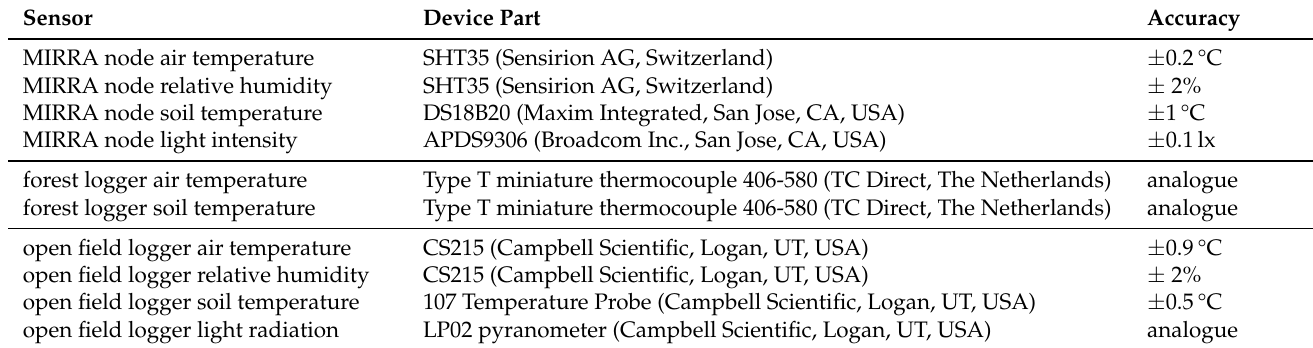
Table 3. Sensor overview in the trial. Accuracies are as specified by the manufacturer in the datasheet. For analogue sensors, the accuracy cannot always be included because it is determined by a combination of the sensor accuracy and sensitivity, cabling and data logger